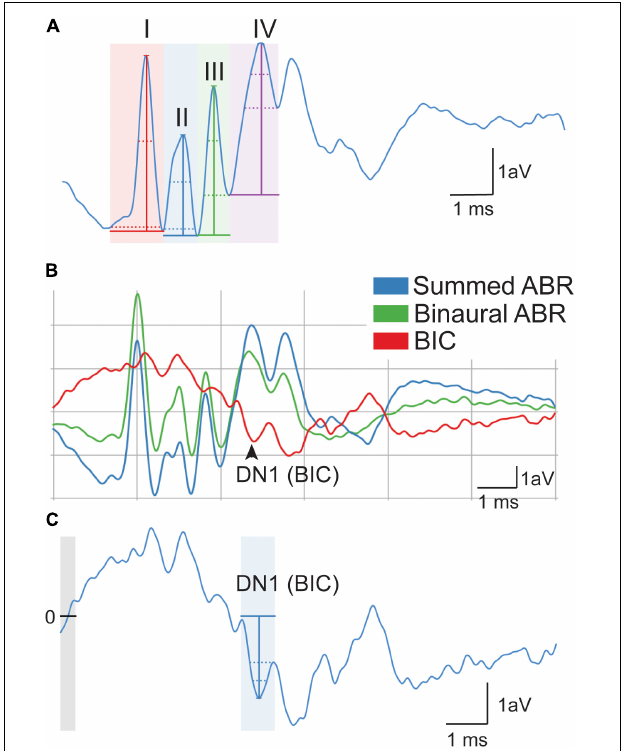
FIGURE 2 | Quantification of auditory brain stem response (ABR) signals. Monaural ABR amplitudes were quantified for each ear as the voltage between the peak of the ABR and trough of the waveform for waves I–IV (A) . Latency was calculated as the time when the height of the peak occurred. DN1 or binaural interaction component (BIC) (i.e., red) was calculated as the prominent negative peak corresponding with wave IV of the summed (blue) and binaural (green) (B) . BIC is calculated as the summed ABR subtracted from the binaural ABR. The BIC amplitude was calculated as the voltage at the peak of the DN1 waveform to the baseline (0, line, and gray area) of the measurement (C) . The scale represents 1 arbitrary voltage (aV) unit (Y) during 1 ms